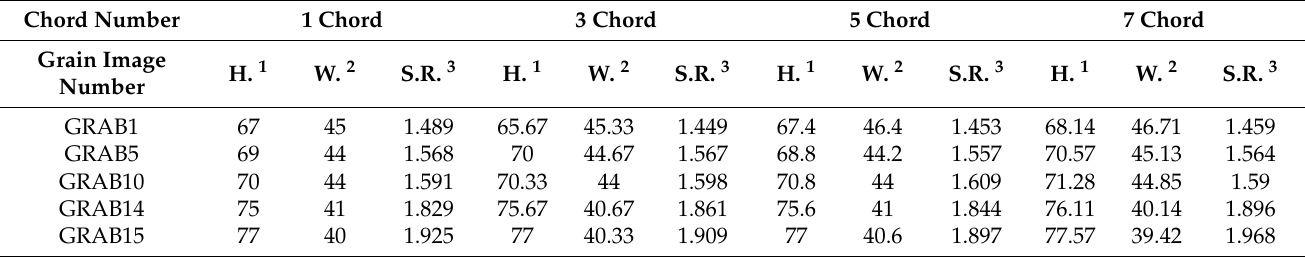
Table 1. The multi-chord grain fitting data and shape parameters (grain 1).